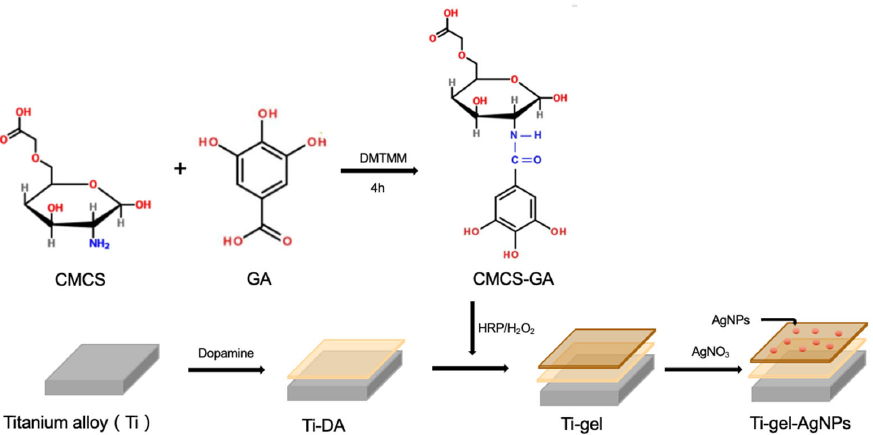
Scheme 1. Schematic illustration of the fabrication of the bioactive surface coating onto the titanium alloy surface. Ti ‐ DA represents Ti with dopamine. Ti ‐ gel represents Ti with CMCS ‐ GA ‐ gel. Ti ‐ gel ‐ AgNPs represents CMCS ‐ GA ‐